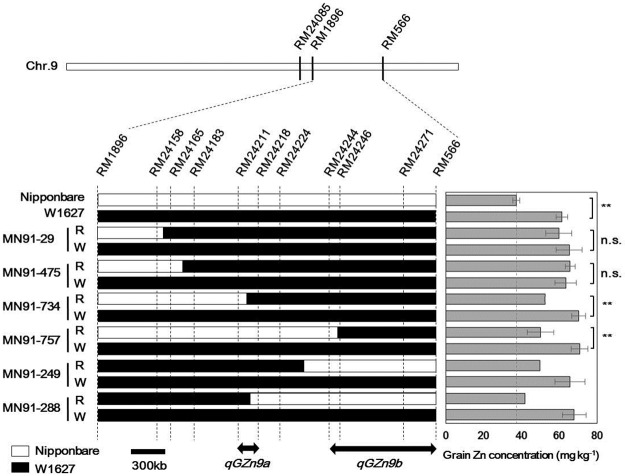
Two independent loci, qGZn9a and qGZn9b, identified in the putative qGZn9 genomic region on chromosome 9.Graphical genotypes of two homozygous lines with wild (W) and recombinant (R) chromosomes, derived from six critical recombinants. White and black bars indicate ‘Nipponbare’ and W1627 chromosomal segments, respectively. Data are mean ± s.d. (n = 4). The average grain Zn concentrations of two plants from two recombinant lines nos. 249-R and 288-R are shown. n.s. and ** indicate not significant and significant at the 1% level by unpaired Student’s t-test, respectively.